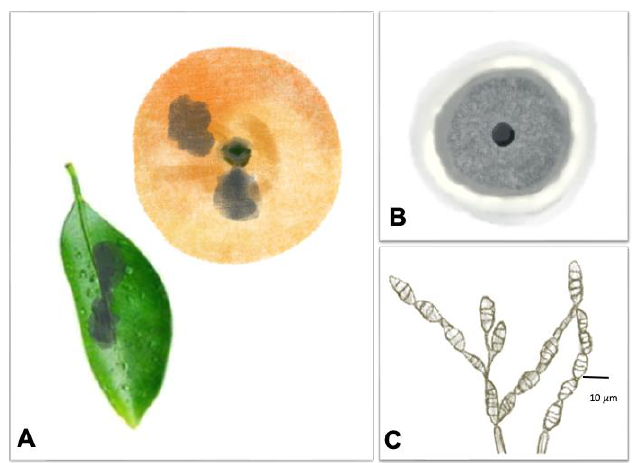
Figure 1. Black rot of citrus fruit causes by Alternaria alternata , ( A ) = the symptom on fruit and leaf; ( B ) = colony and ( C ) = conidia morphology.